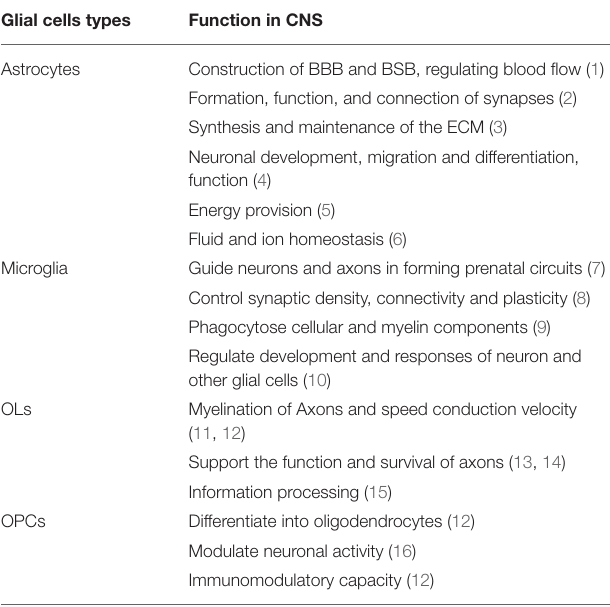
TABLE 1 | Function of glial cells in the healthy